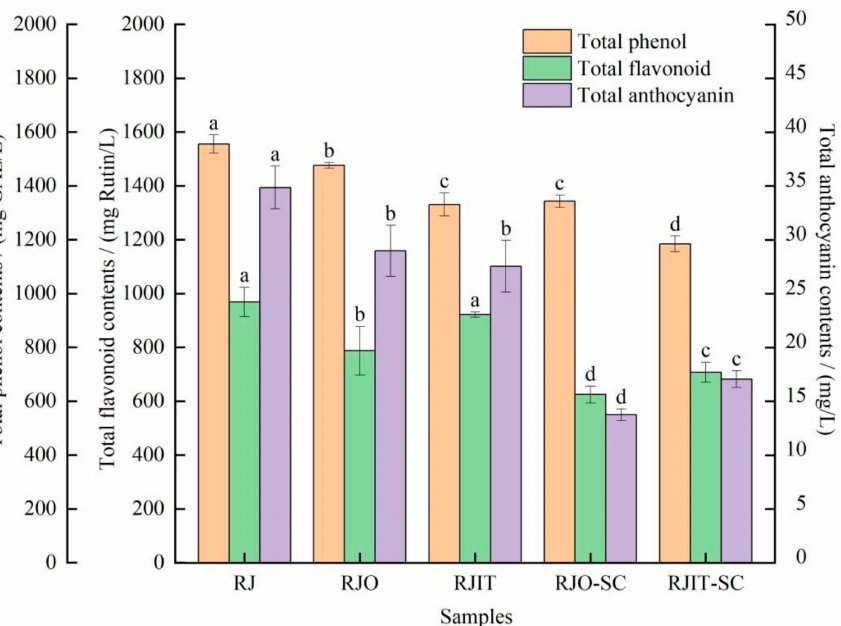
Figure 2. Effect of I. terricola WJL-G4 on total phenol, total flavonoid and total anthocyanin contents of red raspberry wines. Values were given as the means ± standard deviation ( n = 3), and the different letters within the same color were significantly different ( p <